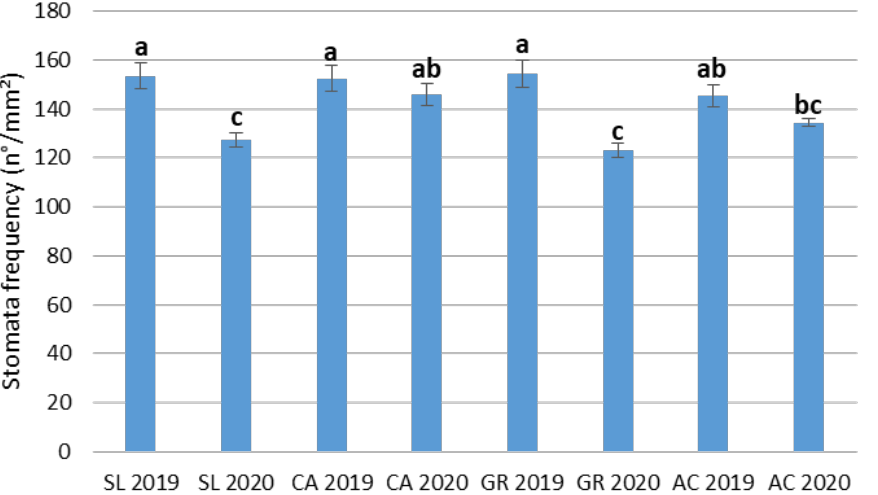
Figure 4. Combined effect of field and year (F x Y) on stomatal frequency of V. vinifera subsp. vinifera ‘Falanghina’ vines at the four study sites: SL-Santa Lucia, CA-Calvese, GR-Grottole, AC-Acquafredde. Mean values and standard errors are shown. Different letters indicate significant differences according to Duncan’s multiple range test ( p ≤ 0.05). Table 4. Effects of field (F), year (Y), and their interaction (F x Y) on vein traits in leaves of V. vinifera ‘Falanghina’ vines at the four study sites: SL-Santa Lucia, CA-Calvese, GR-Grottole, AC-Acquafredde. Mean values and standard errors are